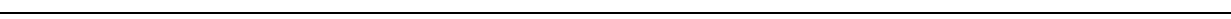
Fig. 7 BAD-LAMP expression promotes TLR9-dependent TNF expression. CAL-1 cells were electroporated with BAD-LAMP mRNA (overexpressed BAD-LAMP) or control non-relevant mRNA (NT) during 6 h before stimulation during indicated times with CpG. a , b ( left ) Immuno fl uorescence confocal microscopy (ICM) on CAL-1 electroporated with BAD-LAMP mRNA or not and stimulated with CpG-A for indicated times. Staining for LAMP1, VAMP3 and BAD-LAMP ( a ) or TLR9 ( b ) is shown. Pictures are representative of at least three independent experiments. White arrowheads identify co-localisation area. Scale bars = 5 µ m. ( right ) Quanti fi cation of the co-localisation between BAD-LAMP ( a ) or TLR9 ( b ) and VAMP3 ( red lines ) or LAMP1 ( blue lines ) between control ( full lines ) and transfected cells ( dashed lines ) upon CpG-A stimulation was performed by Pearson ’ s coef fi cient measurement using ImageJ. Graphics represents mean of Pearson ’ s coef fi cient of at least 25 cells ± s.d. for any time point. c , d IFN α 2 ( left ) and TNF ( right ) mRNA ( c ) or protein ( d ) level were monitored by RT-QPCR or ELISA respectively. e ( top ) Voxel gating analysis after ICM on control (NT) or transfected cells with BAD-LAMP mRNA and treated during 3 h with CpG-A. Voxel gating was performed on TLR9 ( green ) and VAMP3 ( red ) channels to generate a ‘ Coloc channel ’ picture only showing VAMP3 + TLR9-containing endosomes. This new ‘ Coloc channel ’ was then merged with single IRF7 staining. Arrowhead indicates co-localisation area. Scale bars = 5 µ m. ( bottom ) Quanti fi cation was performed by Pearson ’ s coef fi cient measurement using ImageJ. Graphics represent Pearson ’ s coef fi cient means of 25 different cells ± s.d. from two independent experiments. f ( left ) control CAL-1 cells or expressing FLAG-BAD-LAMP mRNA were treated with CpG-A for indicated times prior lysis and sodium dodecyl sulphate – polyacrylamide gel electrophoresis treatment. Expression of FLAG, AKT, IRF7, p65 NF- κ B subunit and their phosphorylated forms were detected by immunoblot. β -actin is shown as loading control. ( right ) Quanti fi cation of IRF7 ( top ) and p65 ( bottom ) phosphorylation levels normalised to their total form by ImageJ quanti fi cation. * P < 0.05 by unpaired student ’ s t